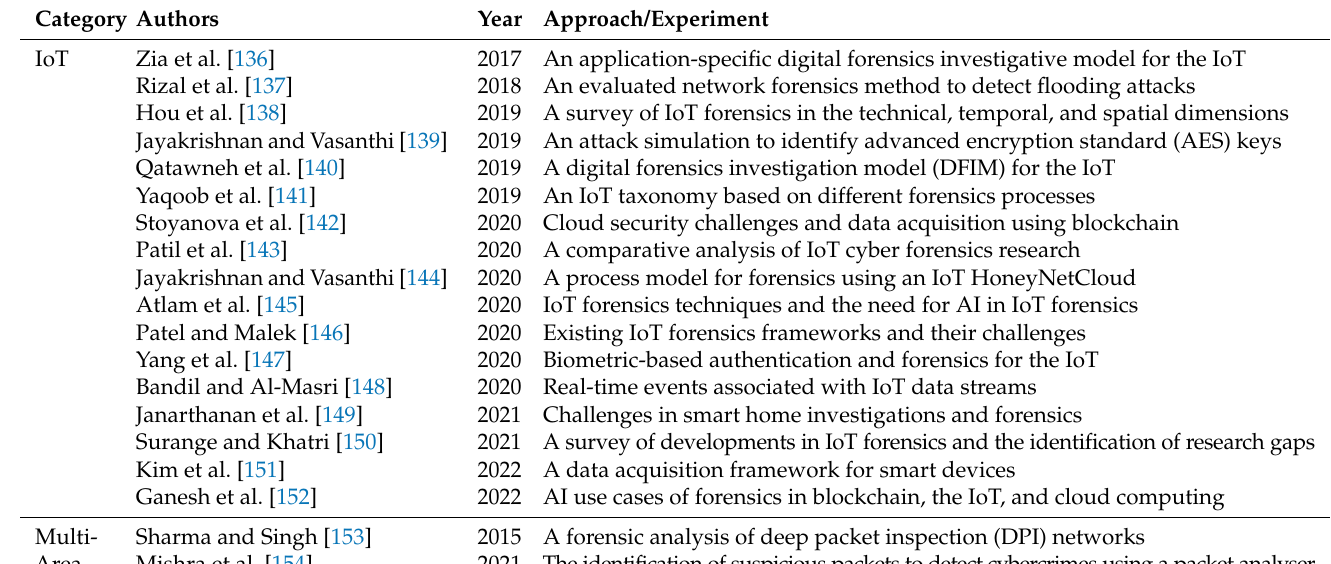
Table 5. A summary of the approaches and experiments presented in existing IoT and multi-area